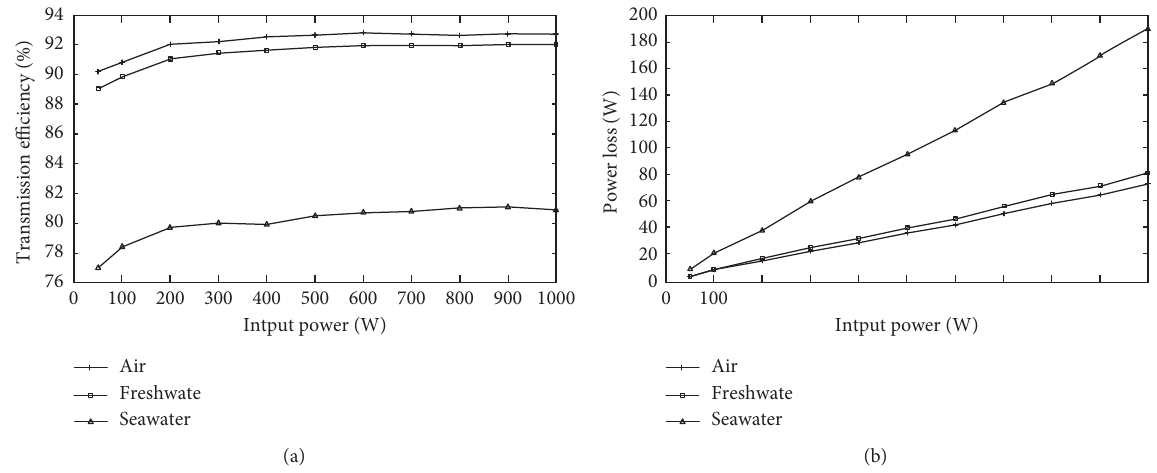
Figure 16: Transmission characteristics with fixed gap. (a) Transmission efficiency with fixed gap. (b) Power loss with fixed gap.